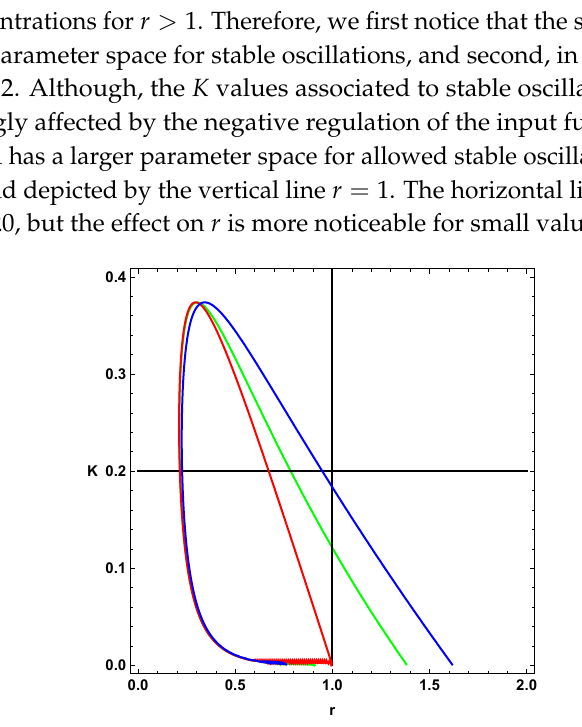
Figure 6. Two-paremeter bifurcation diagram with, k d = 1, k u = 0.01, K = 0.20 and φ = 0. Red implies constant input; blue implies m = 1; and green implies m = 2. See Equation